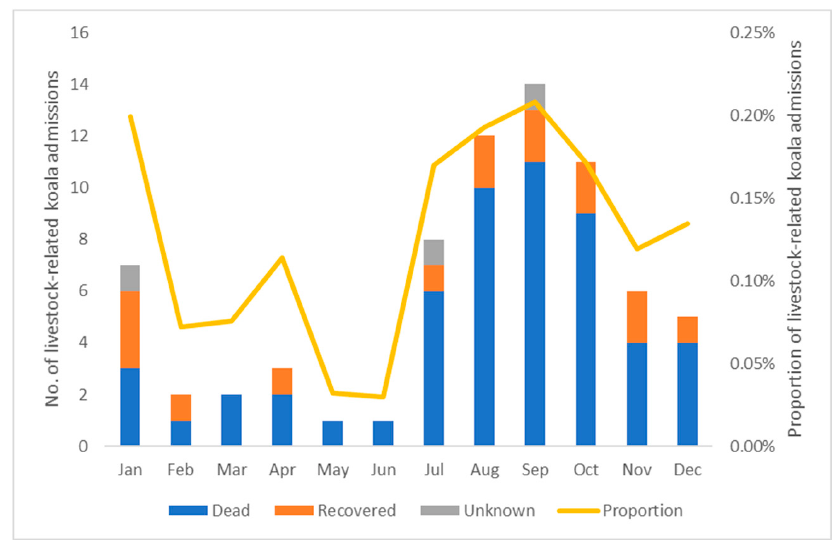
Figure 2. The number of livestock-related koala admissions with their outcomes and proportion of all koala admissions admitted by Queensland wildlife hospitals in each month from 1997 to 2019.